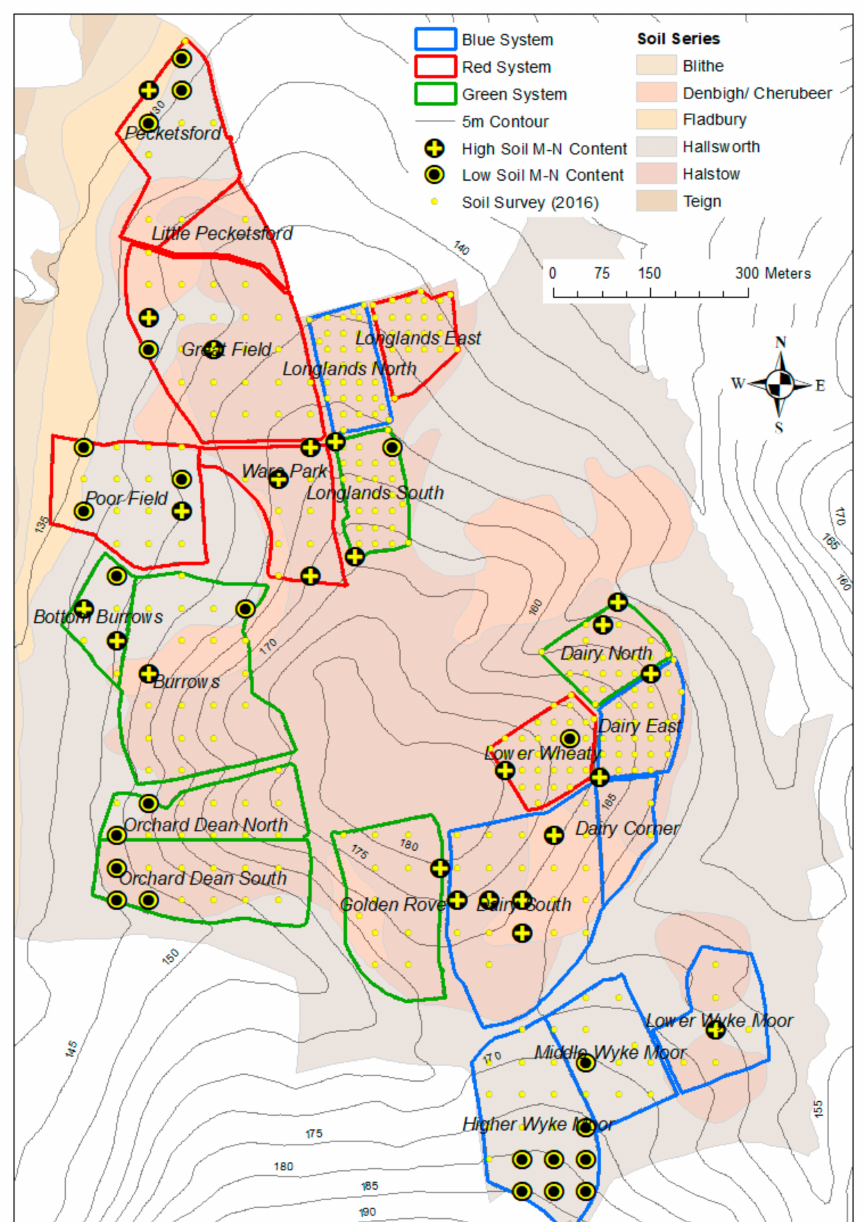
Figure 1. The herbage sampling locations corresponding to high (crosses) and low (circles) soil total micro-nutrient content. Elevation and soil series are also shown, across the NWFP, in the pasture systems: high-sugar grass + legume mix − N fertilizer (blue/HSG + L), permanent pasture + N fertilizer (green/P + N), high-sugar grass + N fertilizer (red/HSG +